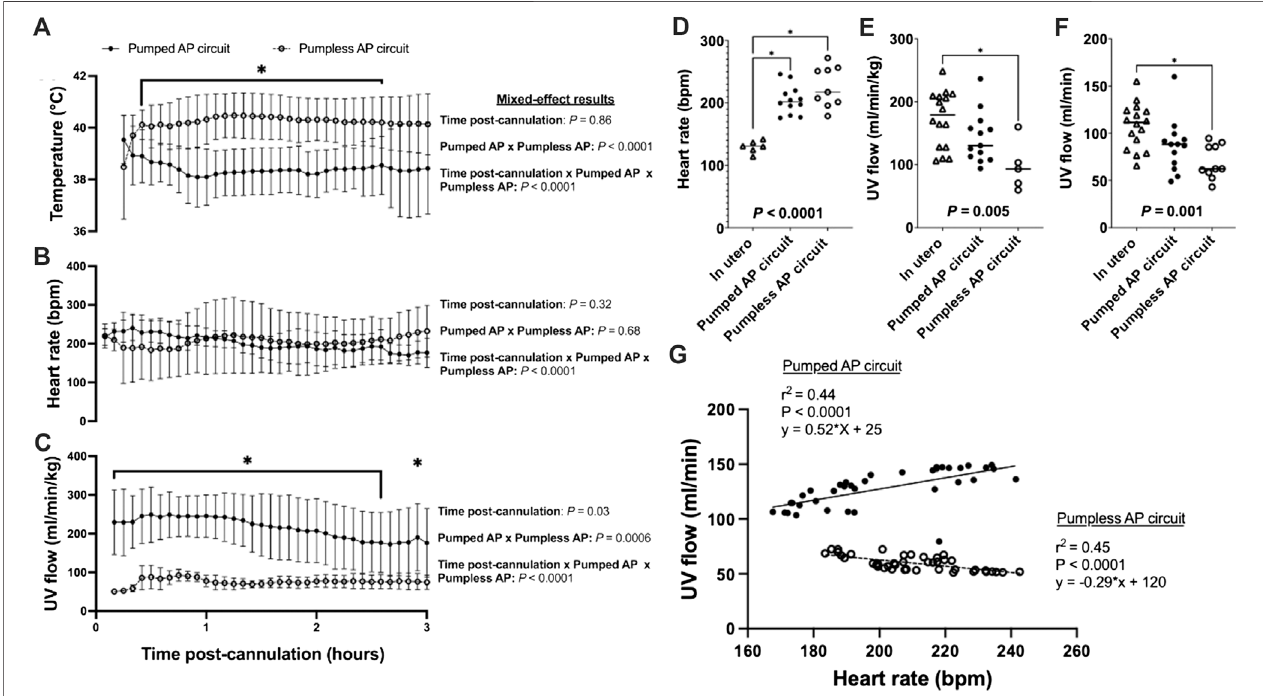
FIGURE2| Fetaltemperature,HR,andUV fl owdatafor inutero ,pumpedandpumplessAPfetalpigs(Charest-Pekeskietal.,2021). (A) Temperature; (B) FetalHR; and (C) UV fl ow vs. time post-cannulation. (D) Mean fetal HR; (E) mean indexed UV fl ow; and (F) mean absolute UV fl ow over the entire duration of support. (G) Correlations between HR and absolute UV fl ow for fetal pigs supported using a pumpless and pumped AP circuit. Fetal pigs maintained on a pumpless AP are represented as open circles and dashed lines ( n = 10 for temperature; n = 9 for HR; n = 5 for UV fl ow), and fetal pigs maintained on a pumped AP circuit ( n = 13 for temperature andUV fl ow; n =12forHR)asblackcirclesand solidline. Inutero fetalpigsarerepresentedasopen triangles ( n =6forHR; n =16forindexed and absolute UV), pumpless AP fetal pigs as open circles ( n = 10 for absolute UV fl ow) and pumped AP fetal pigs as black circles ( n = 13 for indexed UV fl ow).